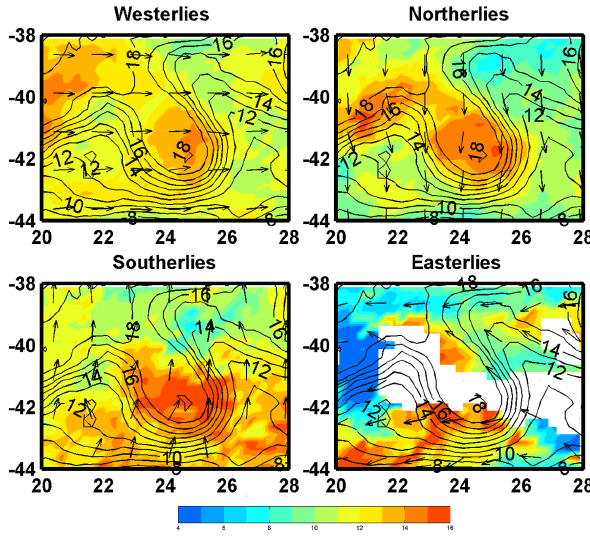
Figure 5. Mean wind speeds in ms − 1 (colour) and directions (ar- rows) and SST in ◦ C (contours) above eddy 5, estimated from twice daily QuikScat wind estimates for westerly (36 cases), northerly (18), easterly (1) and southerly wind (6) during July 2003 showing that wind increases for all